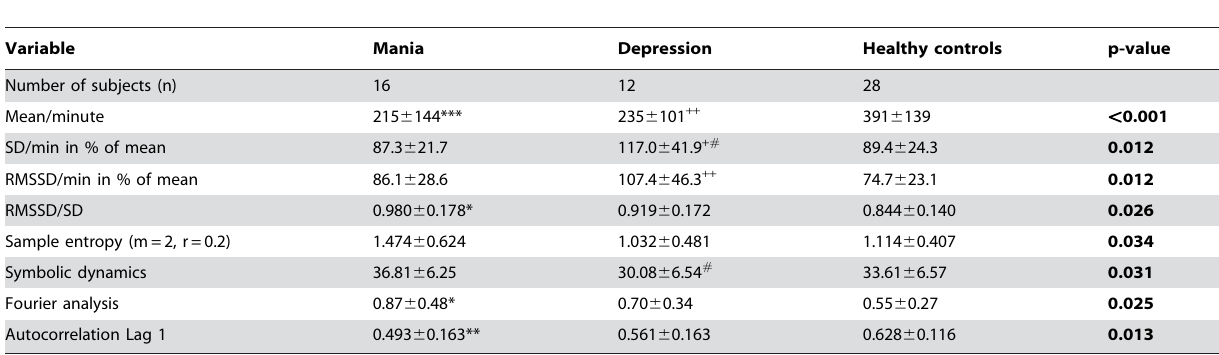
Table 4. Results from the 64-minute period of continuous motor activity in the